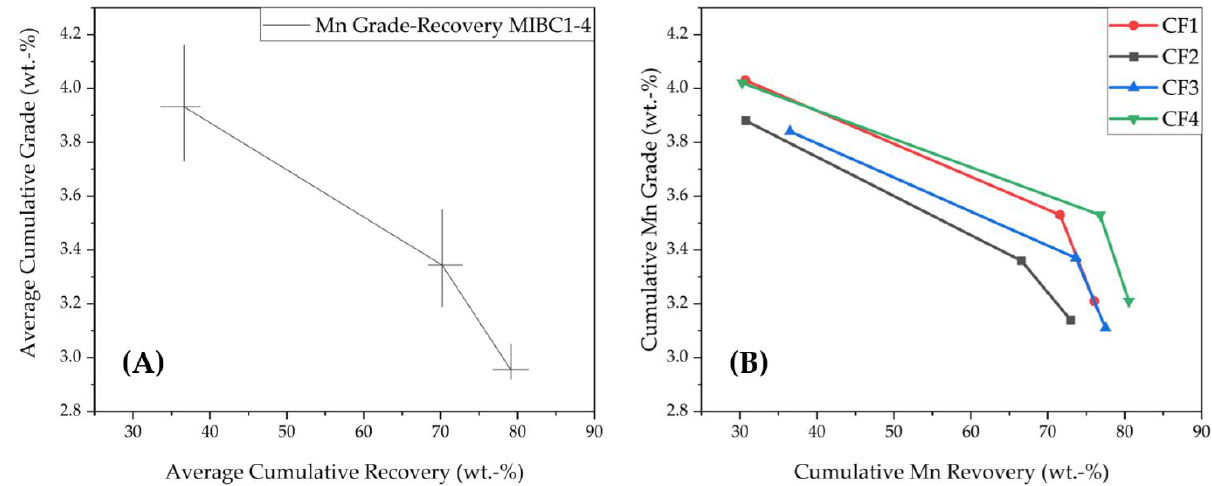
Figure A1. The grade–recovery curves for Mn in the ( A ) MIBC experiments and ( B ) CellFroth experiments.